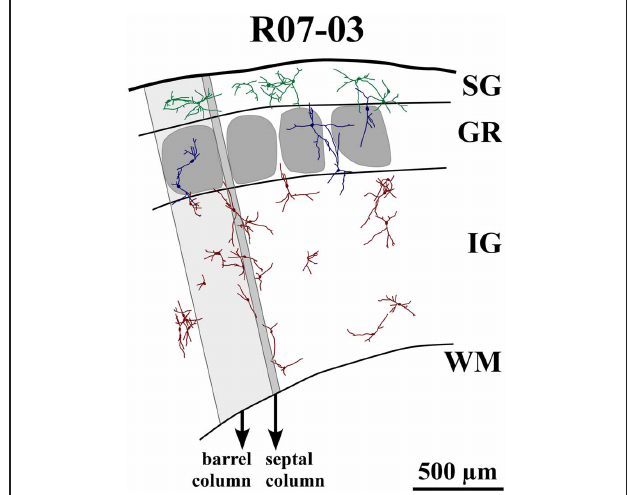
FIGURE 4 | Reconstruction of part of S1 from case R07-03. All nitrergic neurons in this part of the tissue are reconstructed and represented. Barrel and septal columns are delimited by lines that are roughly tangential to barrel borders and orthogonal to cortical surface and white matter (WM) boundaries. One barrel column (shaded light gray) and one septal column (shaded dark gray) are depicted for illustration. Neurons from different cortical layers are represented with different colors. Neurons seem randomly distributed with dendrites crossing the limits of barrels and cortical layers. Most neurons in layer IV (GR) and infragranular layers (IG) tend to display vertically-oriented dendritic trees, while in supragranular layers (SG) neurons are either multipolar or horizontally-oriented. Neurons inside layer IV barrels usually have cell bodies located far from the center of the barrel. Their dendritic trees may cross barrel and laminar borders. The same can be observed in the single GR septal neuron represented in this figure. Neurons seem to cluster in pairs or triplets; but, at the same time, leave blank spaces uncovered by their cell bodies and dendritic